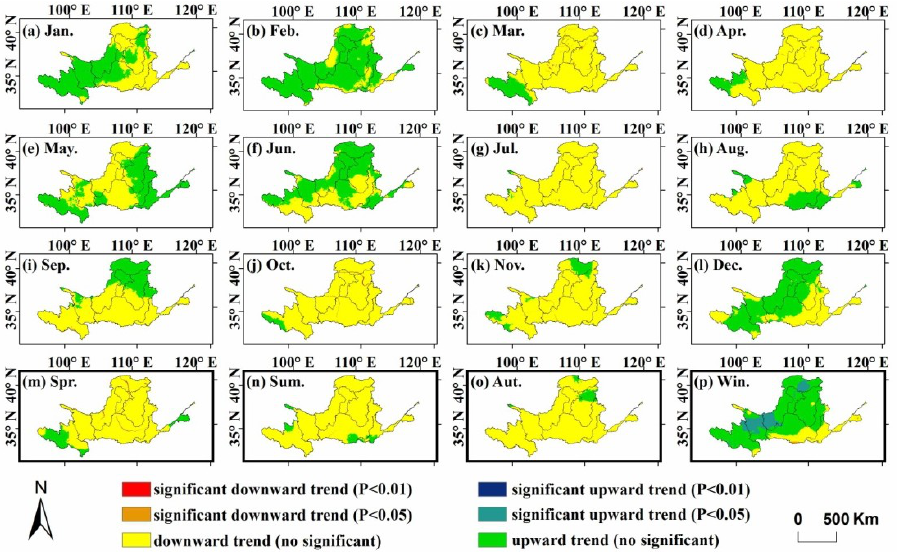
Figure 5. Monthly and seasonal trends of Standardized Precipitation Evapotranspiration Index (SPEI) at the grid scale in the YRB during 1961–2015. ( a )–( l ) denote monthly trends, and ( m )–( p ) denote seasonal trends.